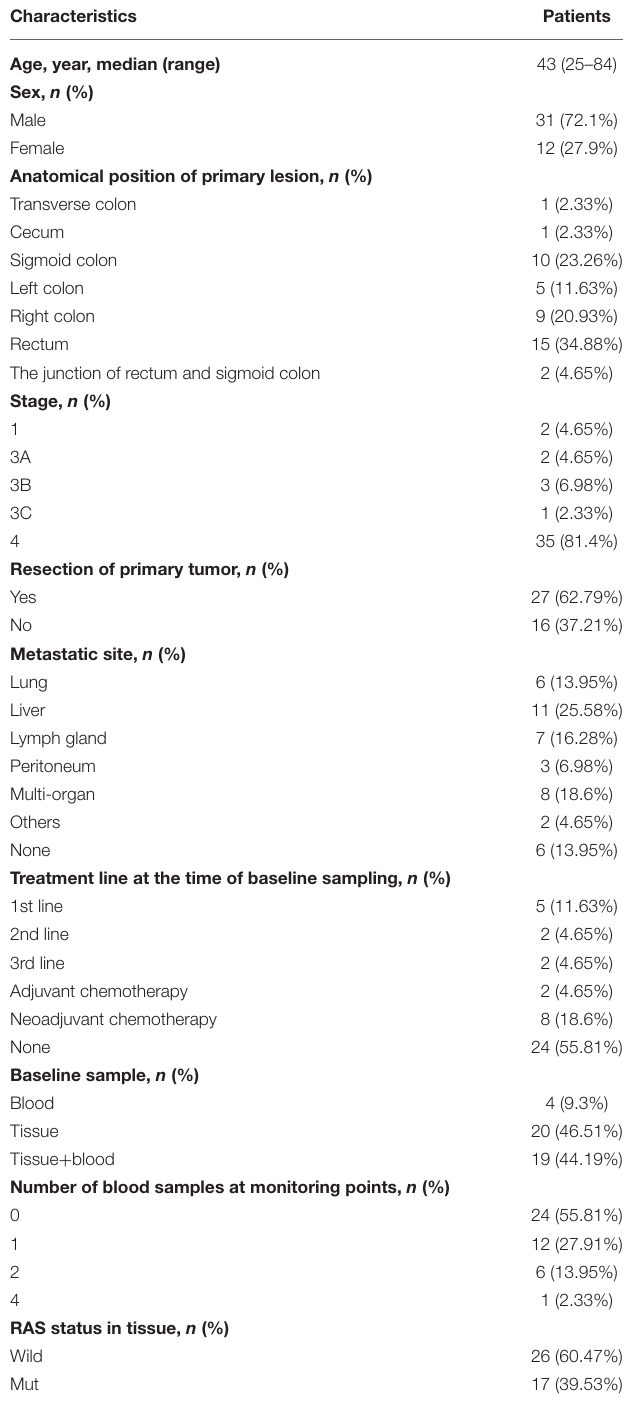
TABLE 1 | Demographic and clinical characteristics of study participants.